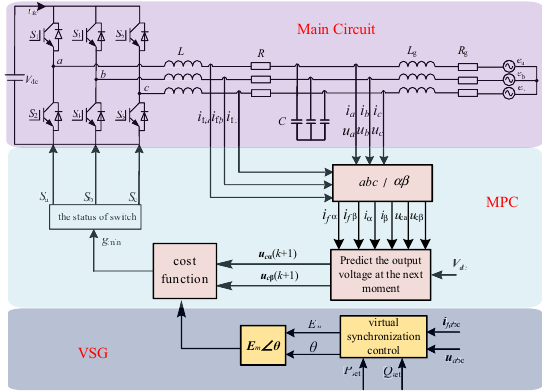
Fig. 4 VSG control block diagram based on voltage model predictive